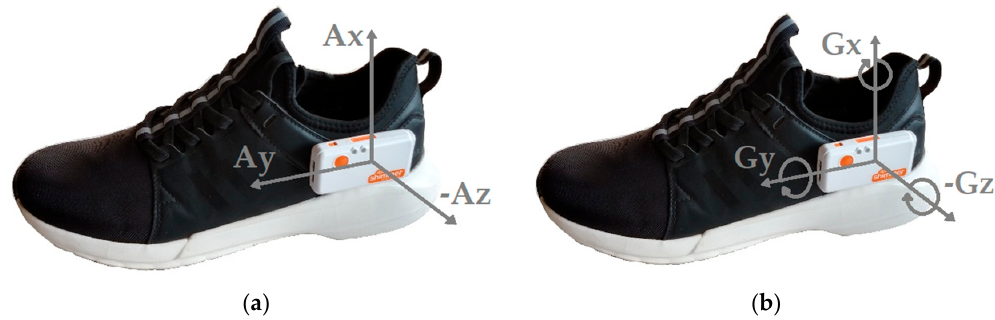
Figure 2. IMU sensor placement and axis alignment. ( a ) Accelerometer. ( b ) Gyroscope.